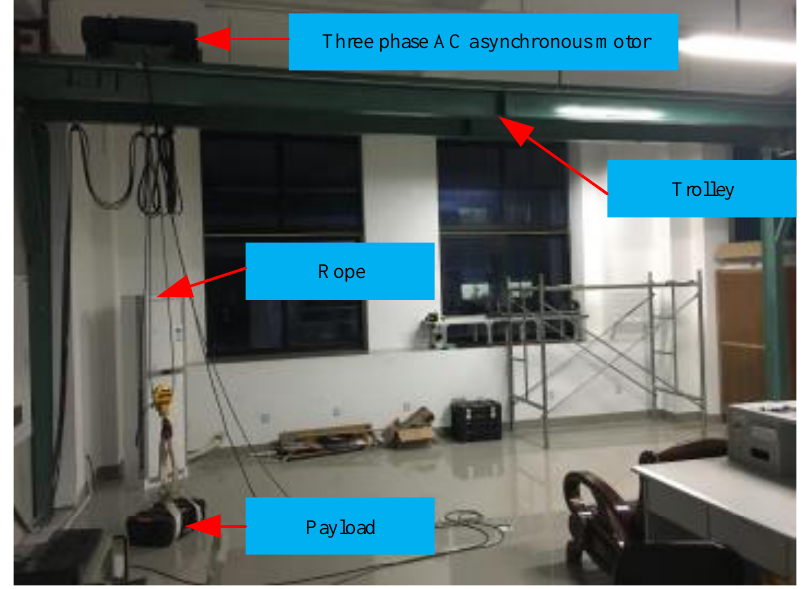
Figure 9. Main mechanical structure of the laboratory-scale overhead crane.